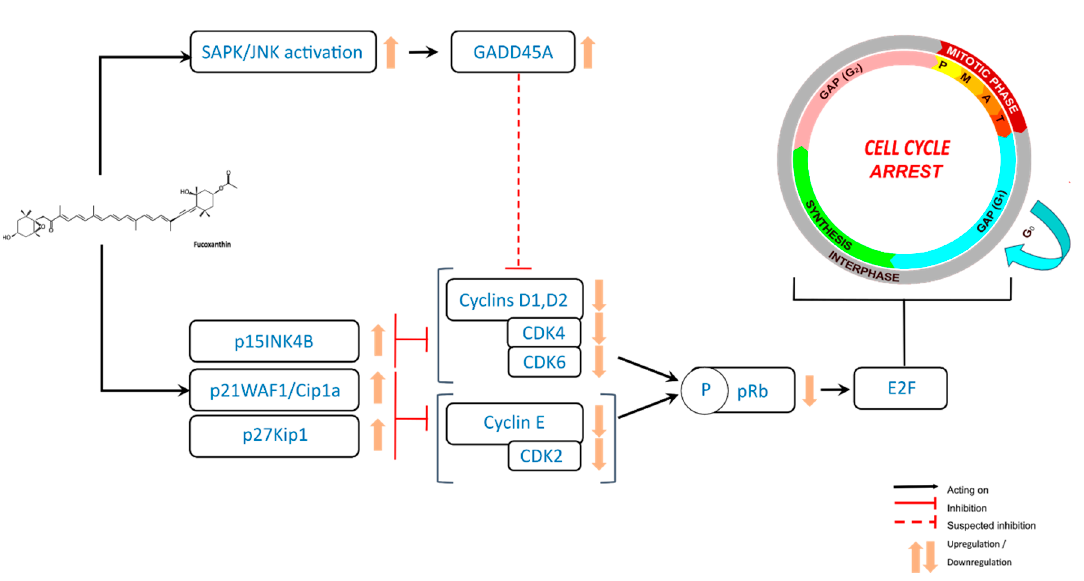
Figure 3. Antiproliferative e ff ects of fucoxanthin through cell cycle arrest in cancer